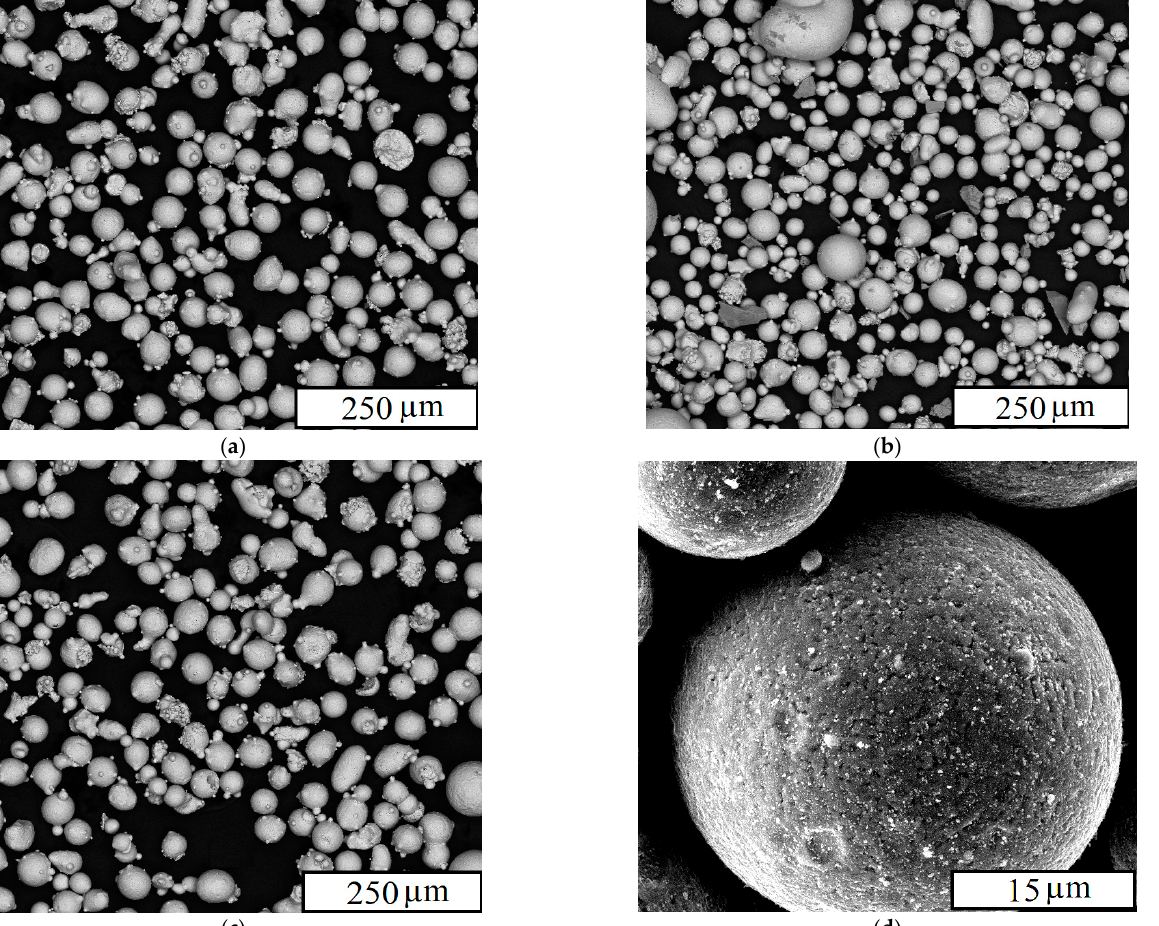
Figure 2. SEM images of the powders: Inc 718 ( a ) (BSE), Inc 718 + 1% micron-TiC ( b ) (BSE), Inc 718 + 1% nano-TiC ( c ) (BSE), nano-TiC particles on the Inconel particle surface ( d ) (SE). Powders’ particle size distribution data are presented in Table 3. All the powders’ particle sizes are Gaussian-distributed, except powder containing nano-TiC, whose distri- bution curve contains a “hump” in a nano-sized area. The mean values of the powders’ particle size are 38.9 µ m, 39.8 µ m and 39.7 µ m for Inc 718 and its mixtures with micron-TiC